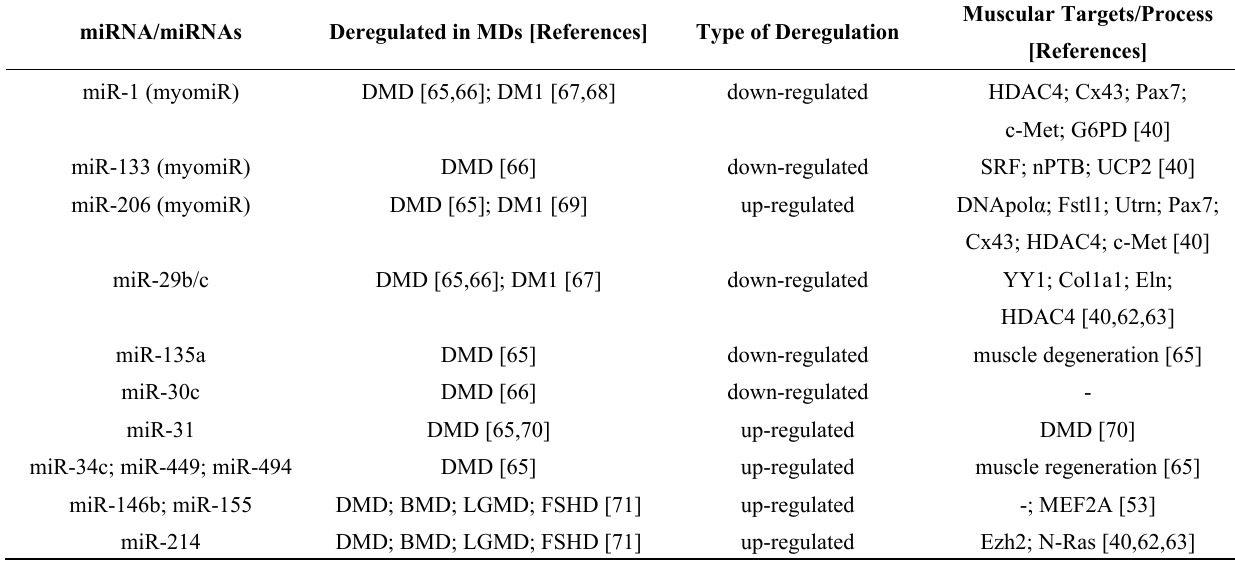
Table 2. miRNAs found deregulated in MDs and their specific activity on muscular targets or involvement in muscular